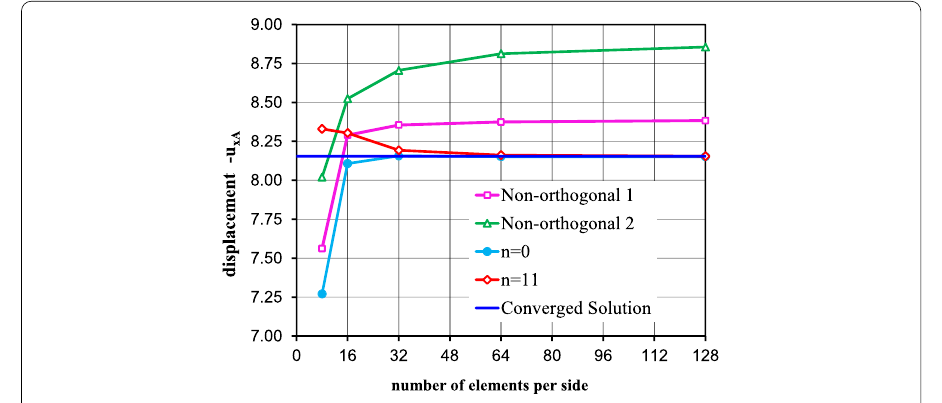
Fig. 10 Hemispherical shell: convergence against a wrong solution when using non-orthogonal functions